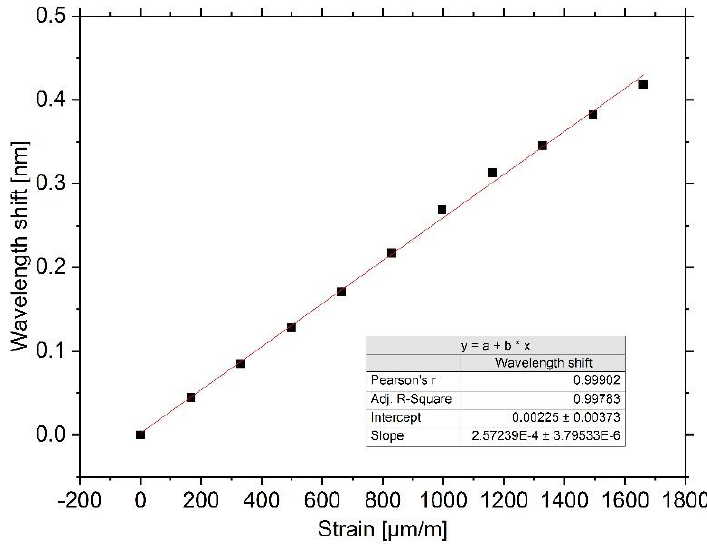
Figure 7. Result of the strain sensitivity experiment. For the investigated range, a linear redshift of the peak with a sensitivity of 0.26 pm/µε exists.